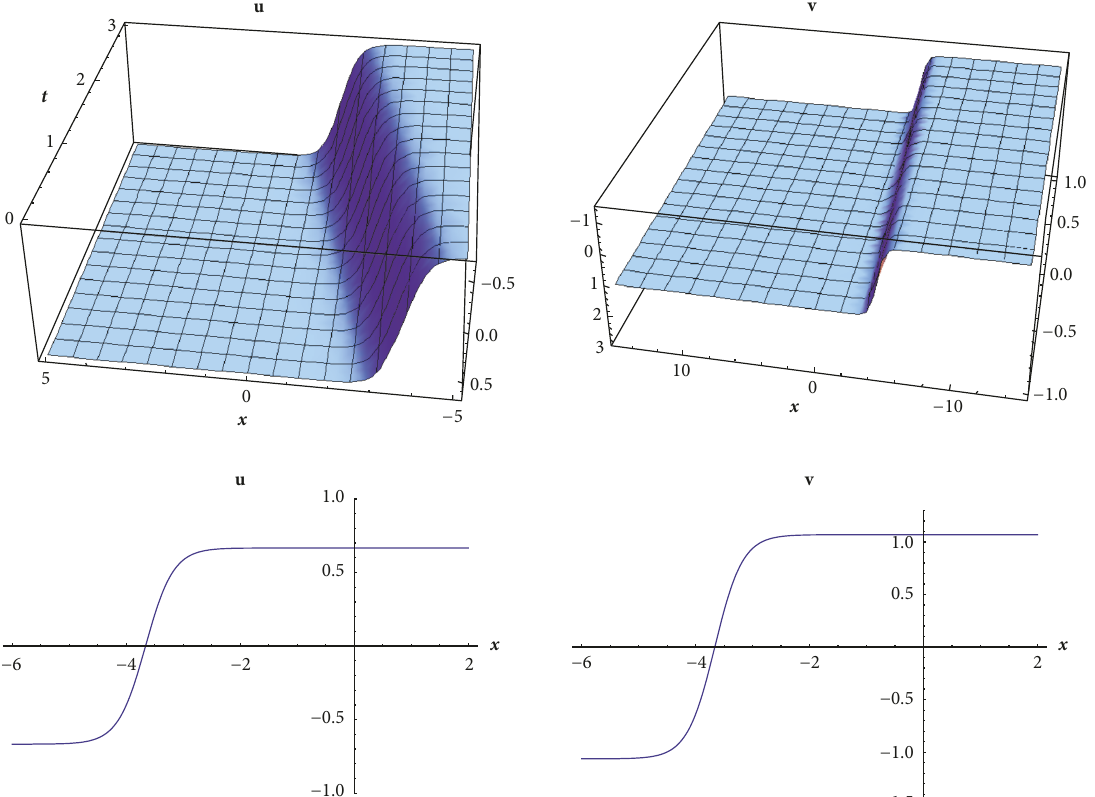
Figure 4: The 3D and 2D surfaces of the solution (25) by considering the values 𝑏 1 = 0.3 , 𝑎 1 = 0.2 , 𝑘 = 1.6 , 𝑐 = 0.8 , 𝑑 = 0.01 , 𝑦 = 1.5 , 𝜖 = 0.9 , and 𝑡 = 0.007 for 2𝐷 .